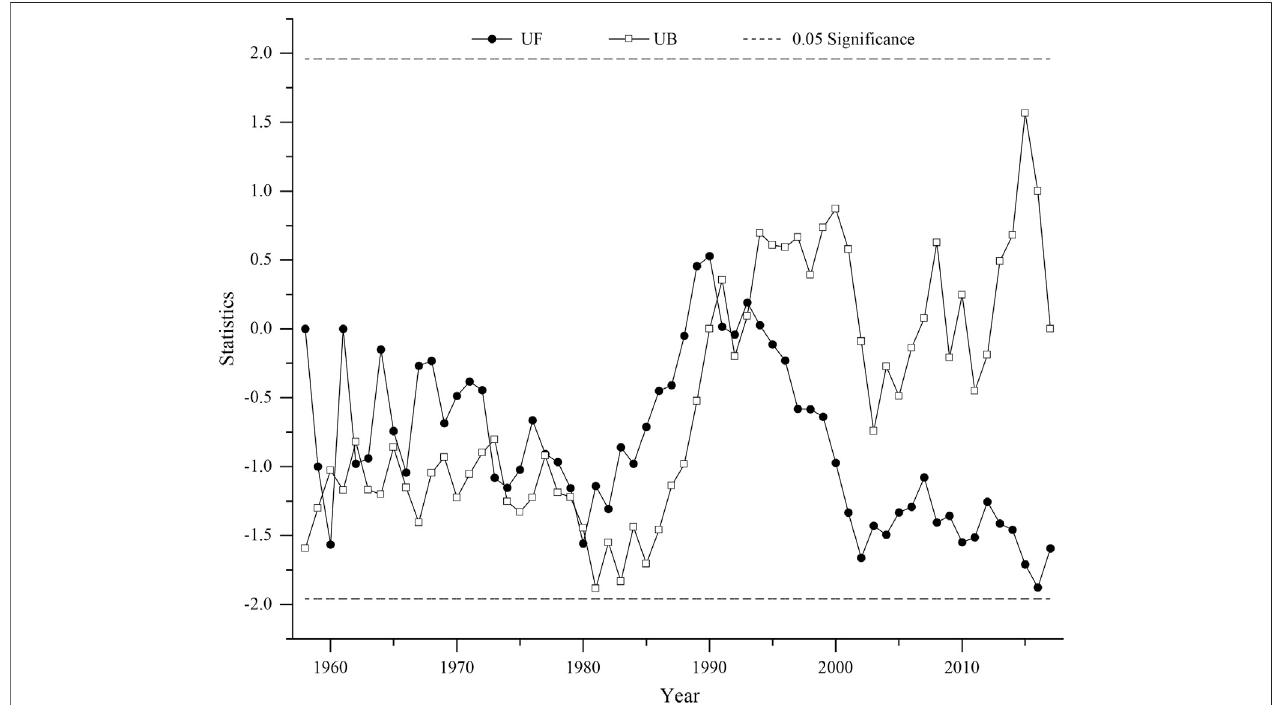
FIGURE 2 | Mann – Kendall change-point detection in time series of annual stream fl ow.